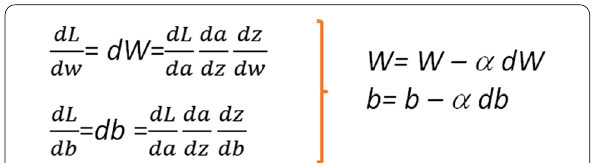
Fig. 9 Derivative calculation using the chain rule and update of the W and b parameters in the direction of the minimum